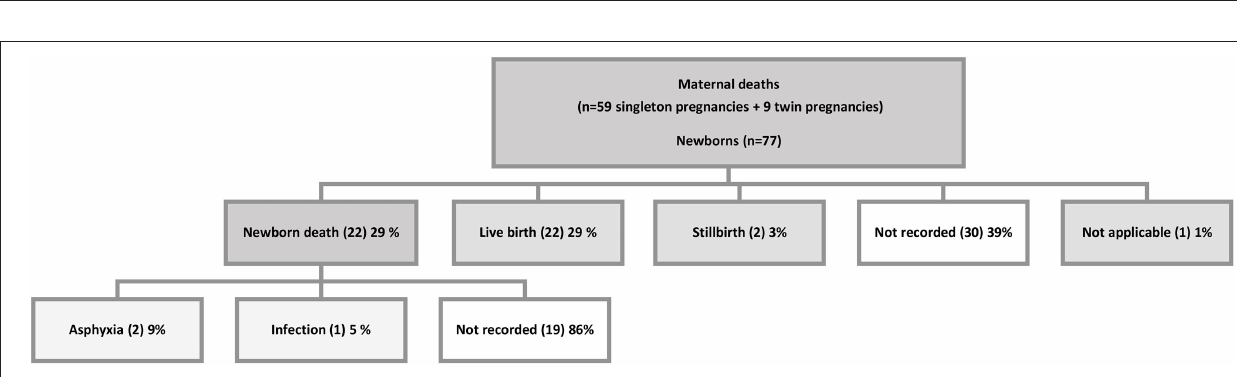
FIGURE 1 | Causes of maternal death recorded in selected charts*.